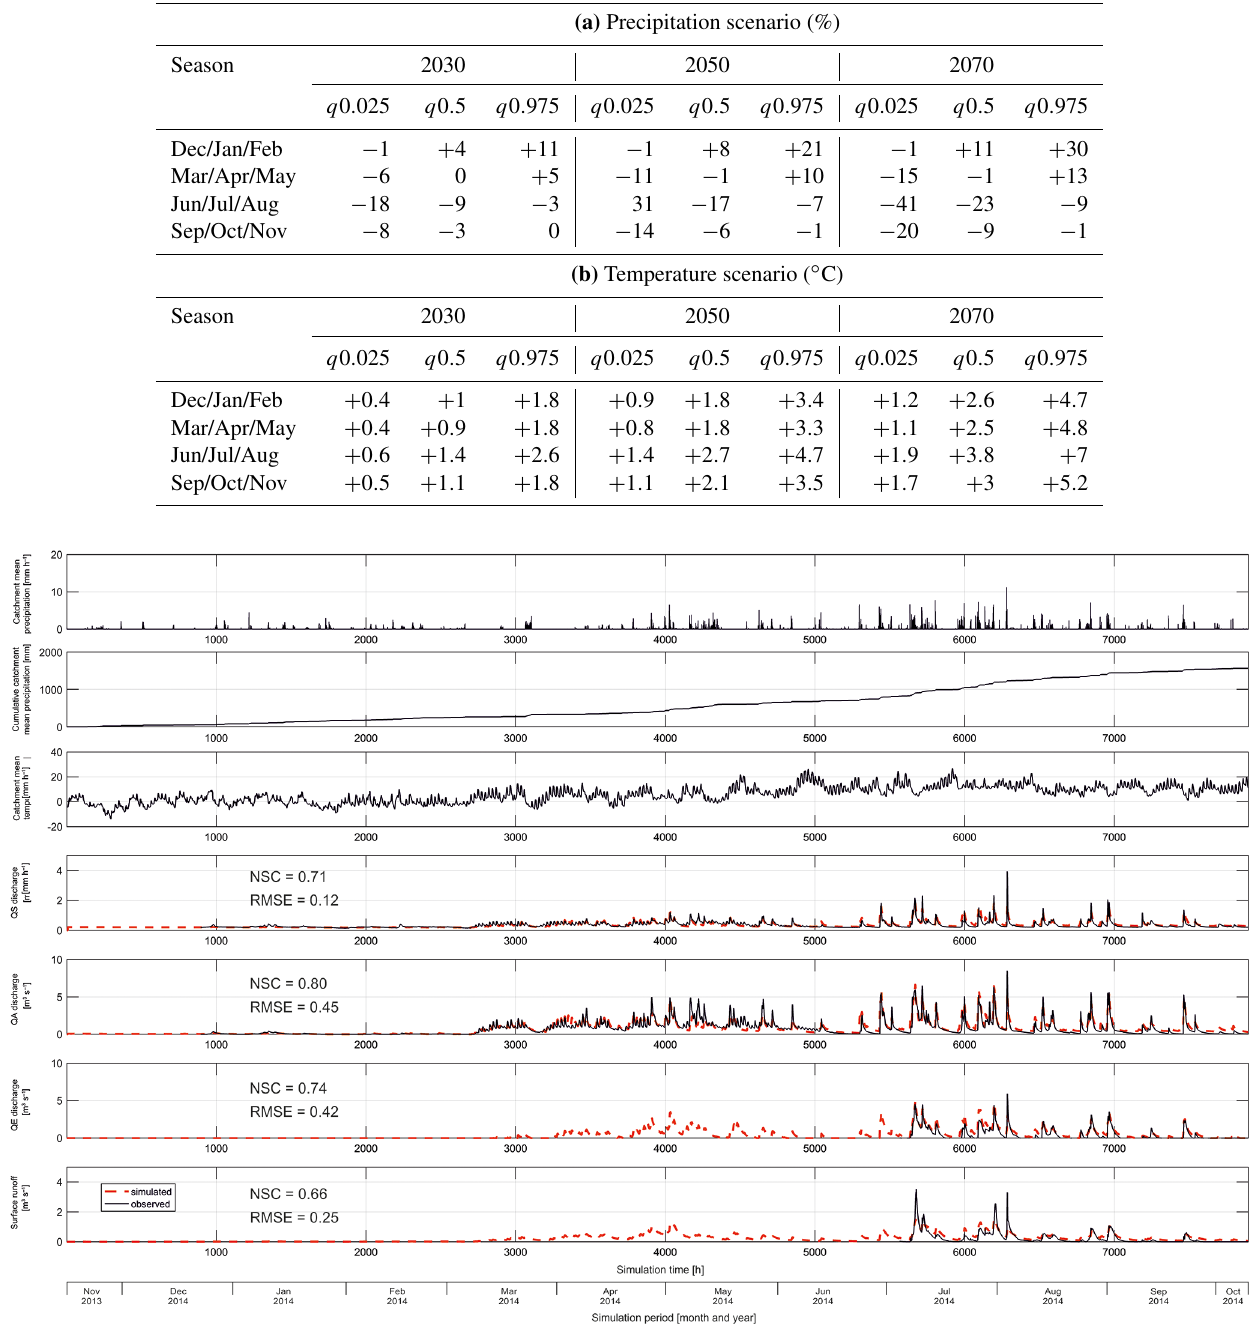
Figure 4. Observed and simulated discharge of four spatially distributed model outlets QS, QA, QE and SR using the best calibrated model parameter set for the period November 2013–October 2014. Additionally, the mean catchment precipitation and temperature for the same period are